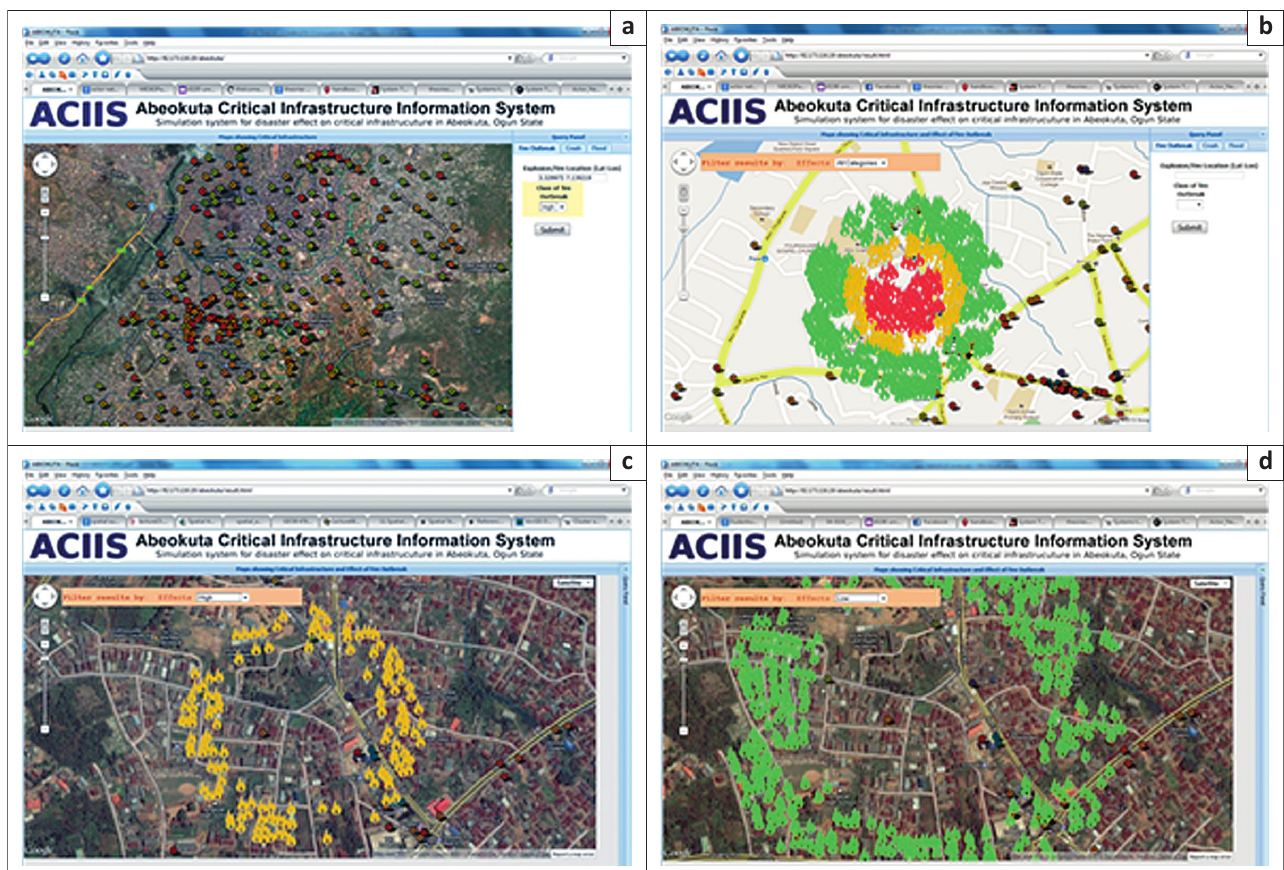
FIGURE 13: Query and result of simulated fire outbreak event: (a) query for simulated fire outbreak; (b) result of the executed query in (a); (c) area of moderate effect of the fire event (d) area of no or low effect of the fire